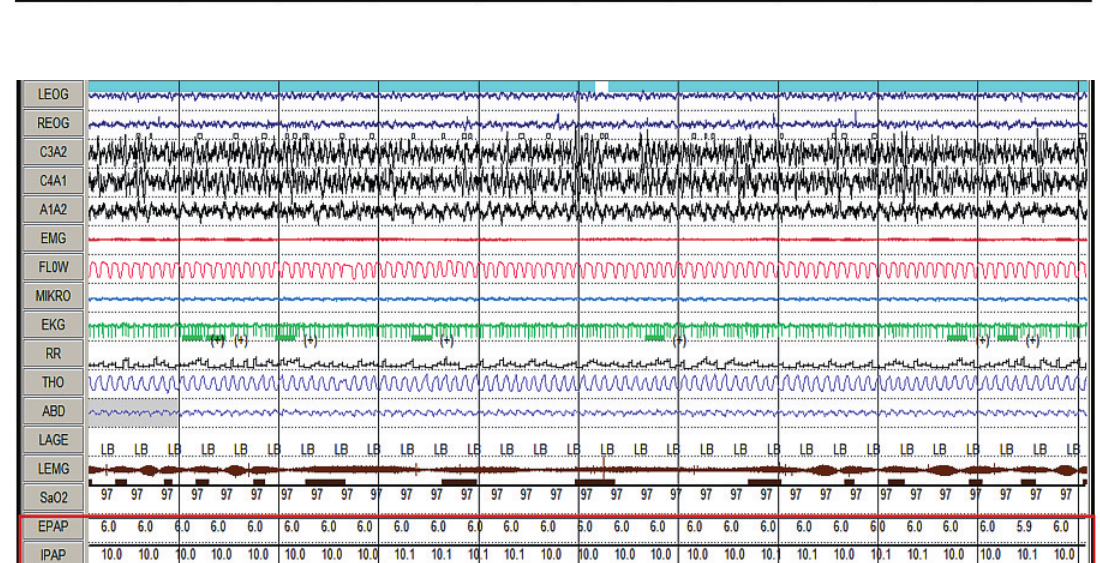
Treatment of Cheyne- Stokes respiration with adaptive servo- ventilation Figure 2a gives an example of 5 min during the first treat- ment with ASV.The red arrow points at a central apnoea which indicates the underly- ing central breathing disorder.The device applies a mandatory breath (blue arrow). The expiratory pressure is fixed at 6 mbar, the inspira- tory pressure varies between 6 and 16.5 mbar to add pressure support. Figure 2b presents the normalisation of breathing under ongoing treatment with ASV.The pres- sure levels are